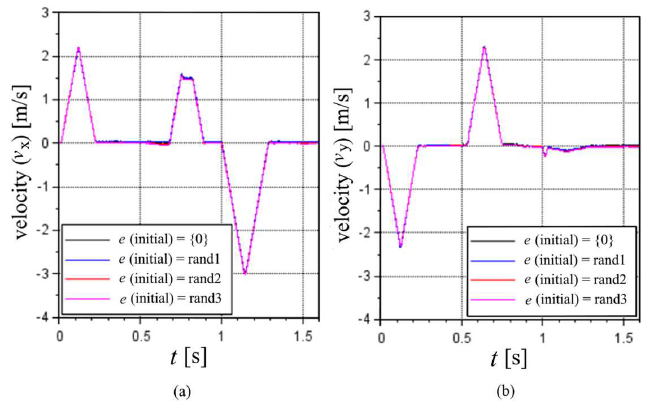
Figure 10. Translational velocities considering different optimized values of e in the ( a ) X axis and ( b ) Y axis, for the first cycle of the 100% MS test.